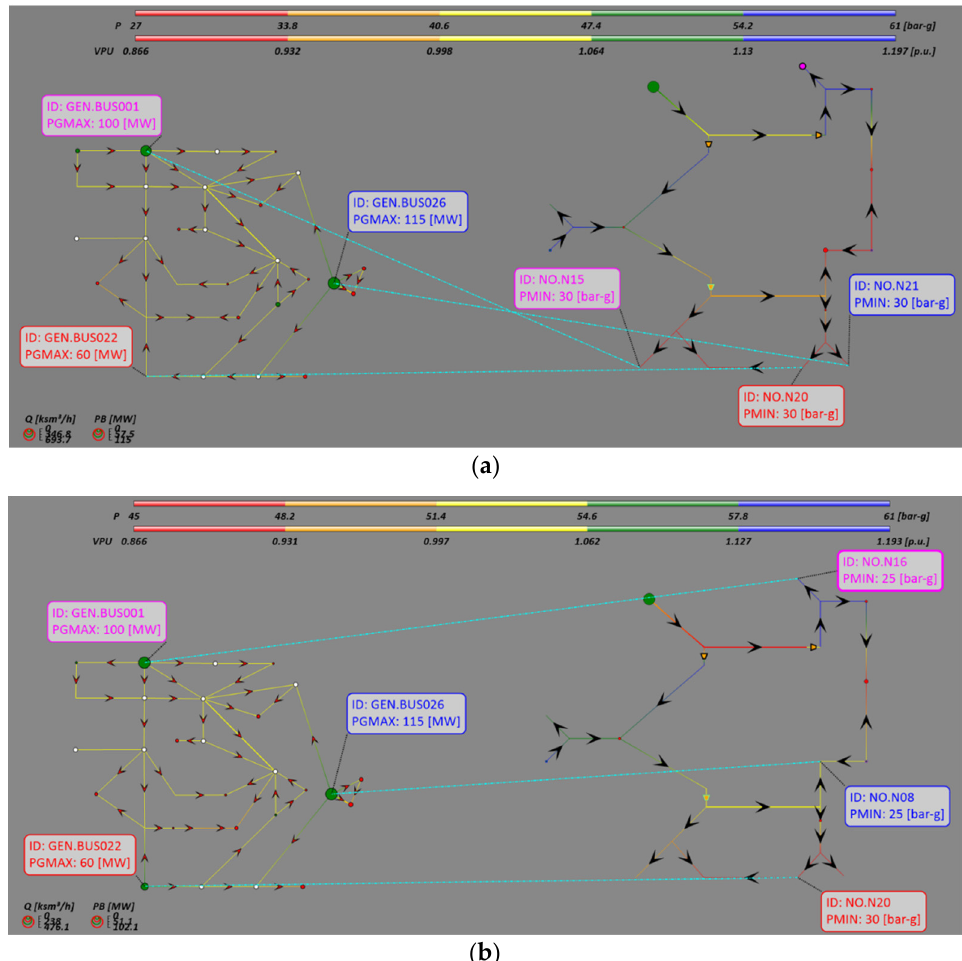
Figure 3. Depiction of the demo electricity (left) and gas networks (right). Circles represent electric buses or gas nodes, while orange trapezoids represent compressor stations. The light blue dashed lines indicate gas-fired power plants and their corresponding offtake node on the gas network. Panel ( a ) illustrates the base configuration, whereas panel ( b ) highlights an alternate configuration of the coupled generators. Table 2. Overview of coupled generators and gas node in each demo network, with details on the minimum delivery pressure (P min ) at each gas generator node.